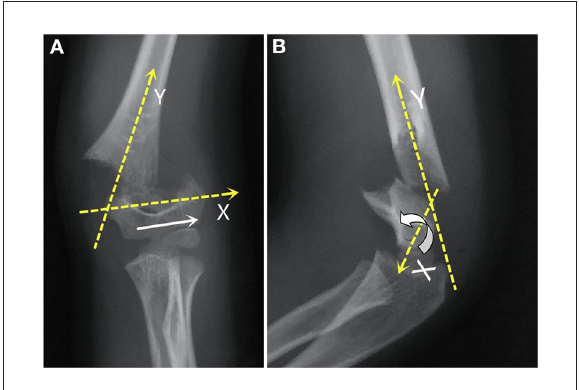
FIGURE2 In the AP view (A) , the distal fragment (white arrow) was anterior-lateral translocation. In the lateral view (B) , the distal fragment was the rotation on the X -axis without an obvious Y -axis rotation.